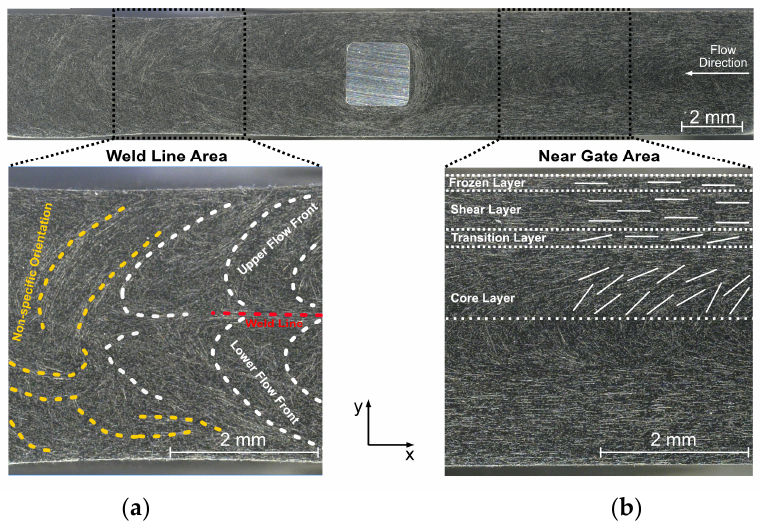
Figure 9. Light microscopic illustration of the examination area (PC CF20_4 mm specimen) with focus on near gate area ( b ) and weld line area ( a ) with schematically marked characteristic fiber orientations.